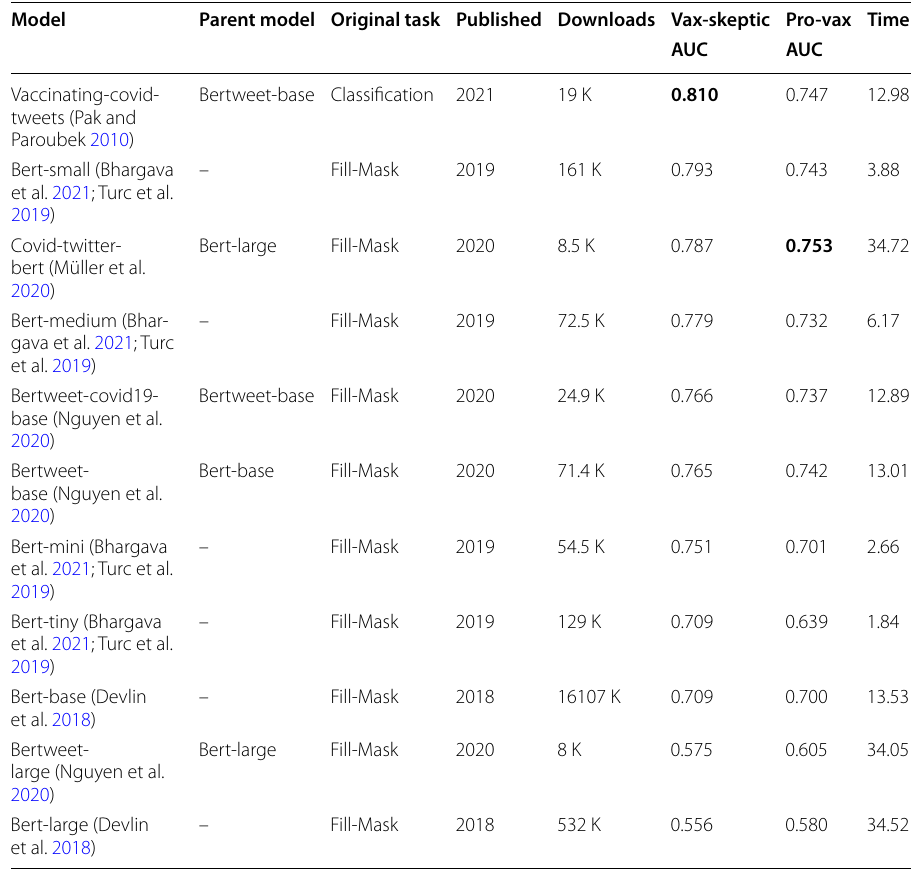
Table 3 Performance (AUC) and query time (seconds) of different BERT models for both vax-skeptic and pro-vaxxer content